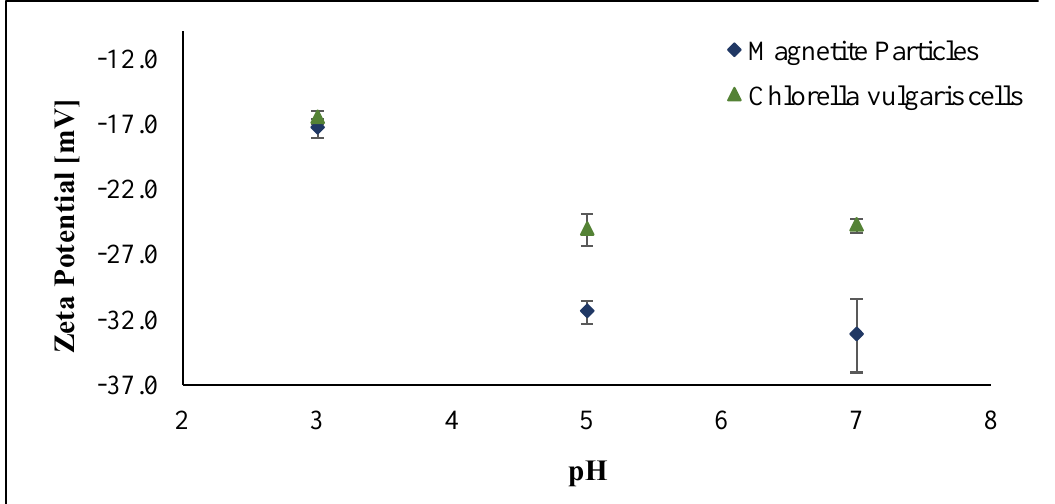
Figure 5. Zeta Potential values of microwave-synthesized Fe 3 O 4 particles and C. vulgaris cells at different pH values of the dispersing medium.